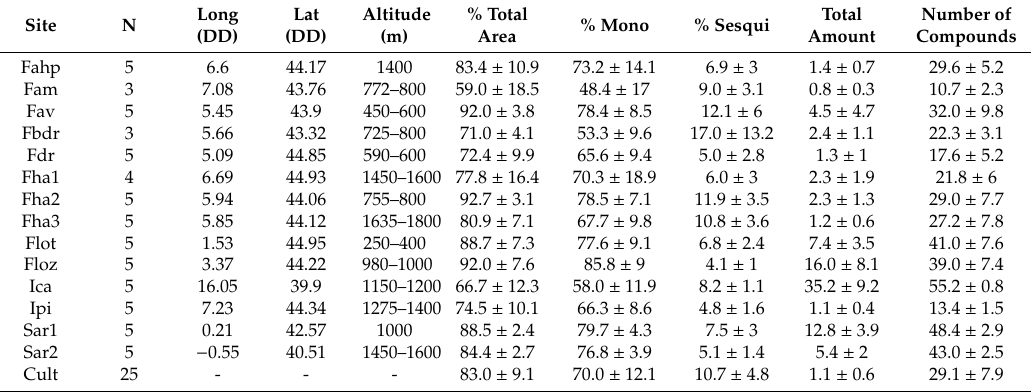
Table 2. Characteristics of the 14 wild lavender sampled sites (site) and the cultivated populations (cult). The characteristics are: number of samples analyzed (N); characteristics of the original localization: Longitude (Long), Latitude (Lat) in decimal degree (DD) and range of altitudes in meter (m); the mean percentage of the total area represented by the 63 repeatable compounds (%Total area), percentage of monoterpenes (%Mono), and percentage of sesquiterpenes (%Sesqui) ± standard deviation; the total amount of extracted compounds (internal standard equivalent per g of dry inflorescence) as well as the total number of compounds ± standard deviation. The codes of sampled sites are: major letter for country (F: France, S: Spain, I: Italy); minor letter for local area (ar: Aragon, lot: Lot, loz: Loz è re, av: Aveyron, dr: Dr ô me, ha: Hautes-Alpes, bdr: Bouche-du-Rh ô ne, am: Alpes-Maritimes, ahp: Alpes-de-Hautes-Provence, pi: Pi é mont, ca: Calabre), and Cult for cultivated